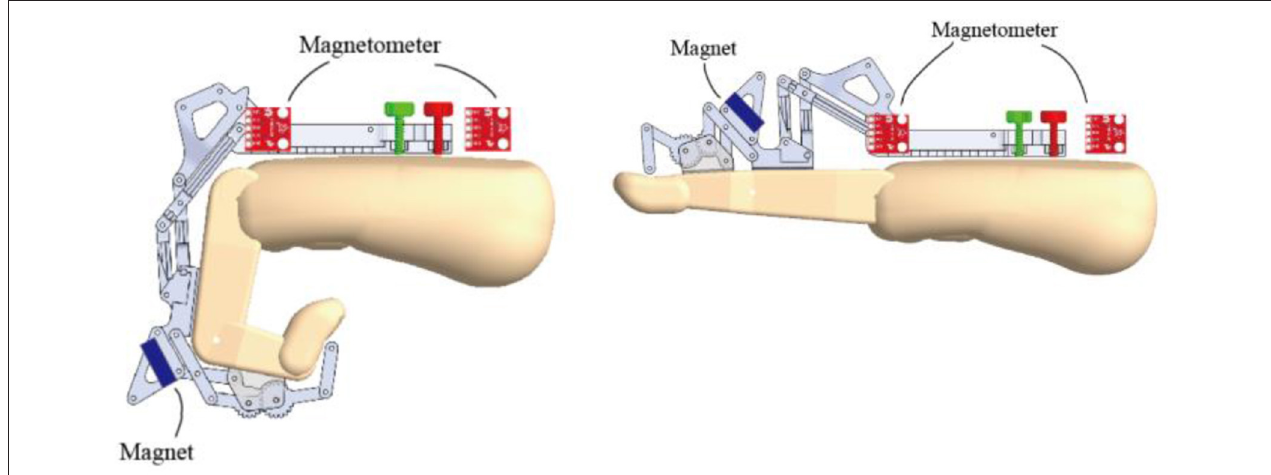
FIGURE 3 | CAD drawing showing locations of magnetometers and magnet during finger extension and flexion. The magnet orientation is affected by both MCP and PIP rotation.